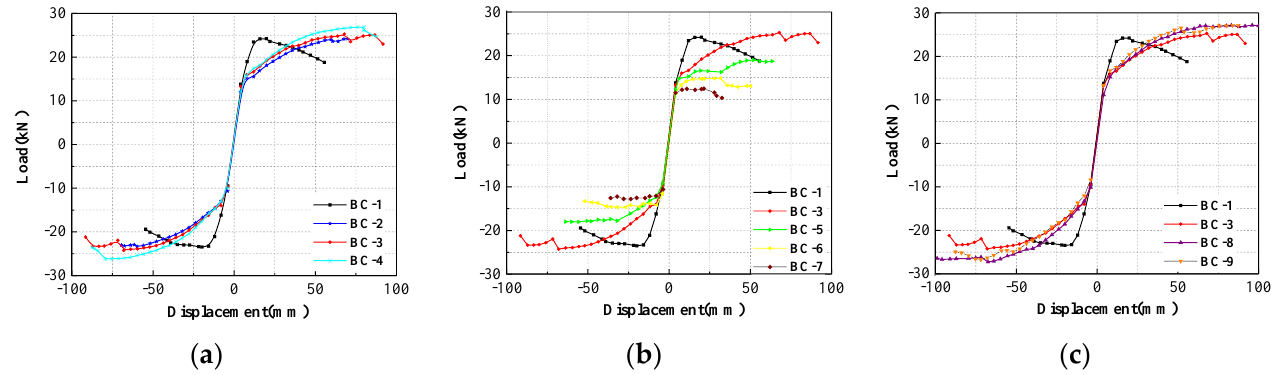
Figure 9. Envelope load – displacement curves. ( a ) Stirrup ratio group; ( b ) Axial pressure ratio group; ( c ) Concrete strength group. Table 6. Feature points of all joint specimens.